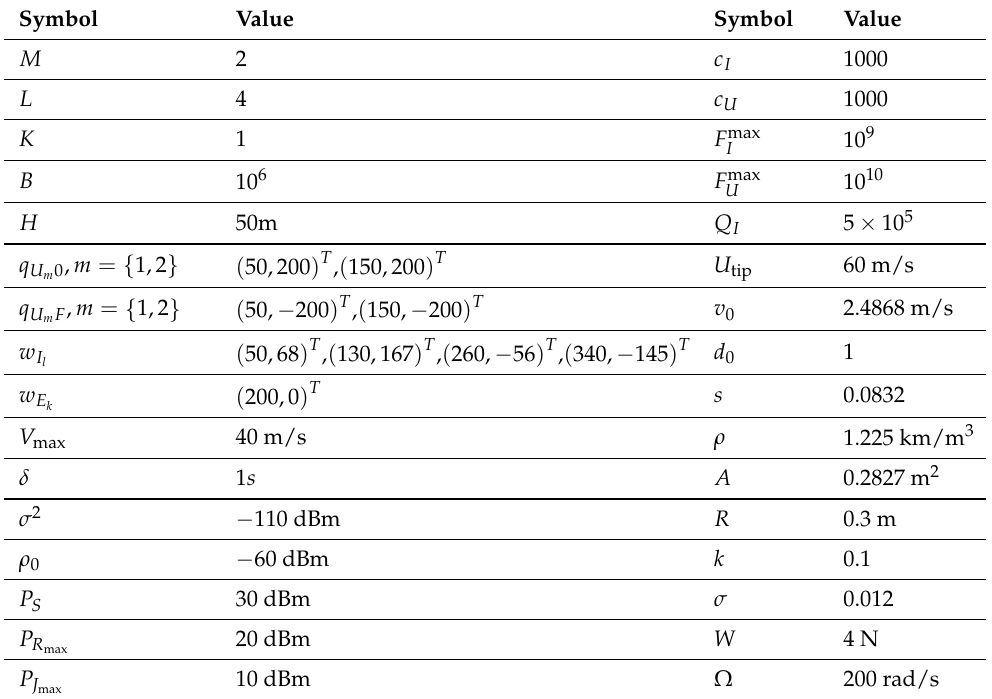
Table 2. Simulation